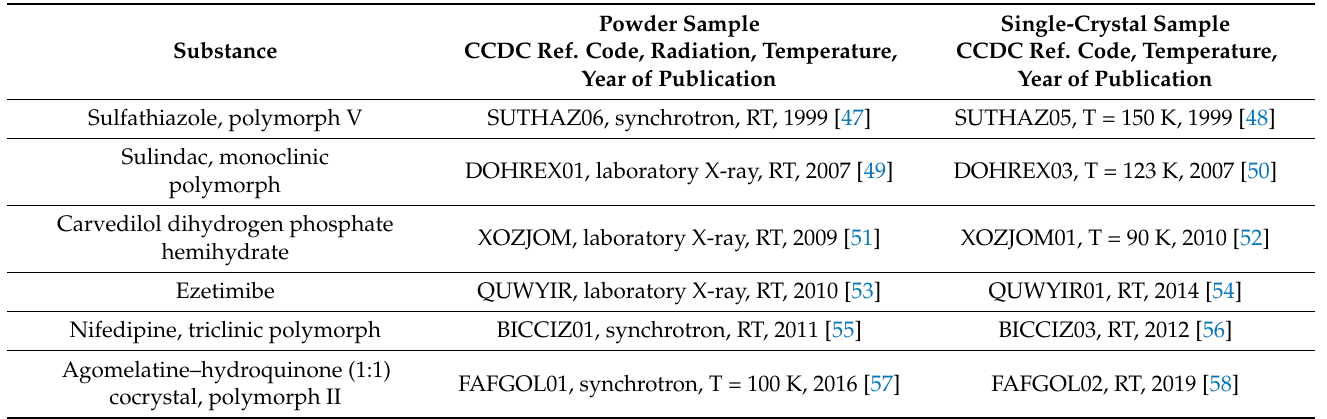
Table 1. Pharmaceutical substances whose crystal structures have been independently determined from powder and single-crystal diffraction